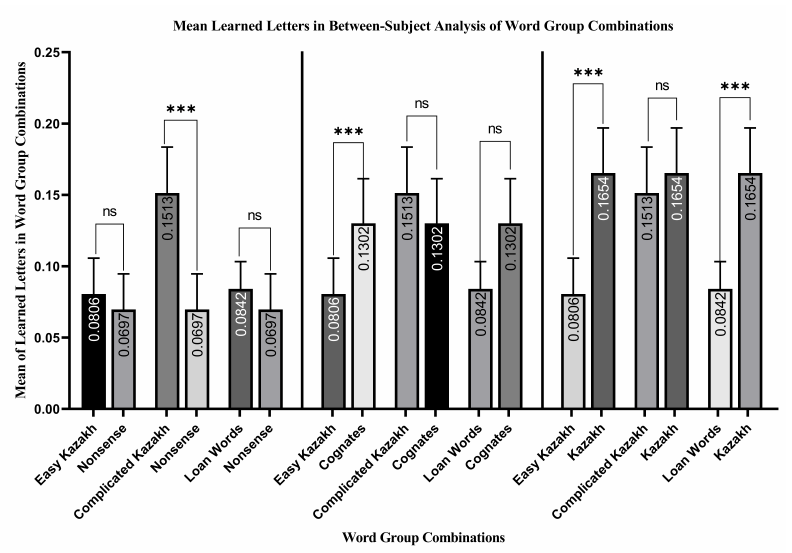
Figure 3. Mean values of learned letters by all word categories in between-subject analysis. p -values larger than 0.05 are summarized as “ns” (not significant), while p -values less than 0.001 are given three asterisks (***) to denote